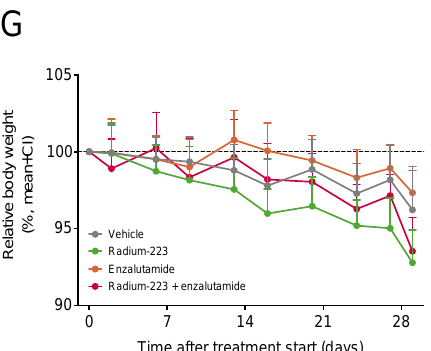
Figure 3. Combination treatment with radium-223 and enzalutamide exhibits enhanced antitumor